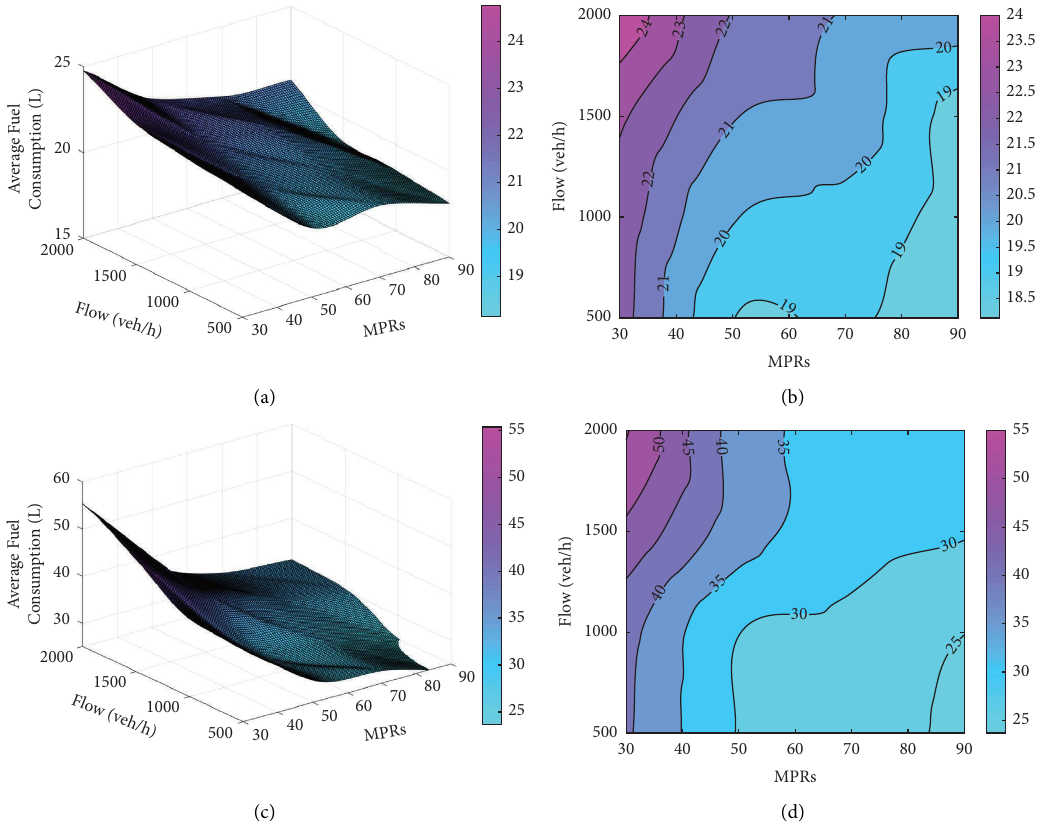
Figure 4: Comparison results of average fuel consumption under diferent volumes and MPRs. (a) Average fuel consumption of the proposed method in 3D. (b) Average fuel consumption of the proposed method in 2D. (c) Average fuel consumption of the benchmark method in 3D. (d) Average fuel consumption of the benchmark method in 2D.